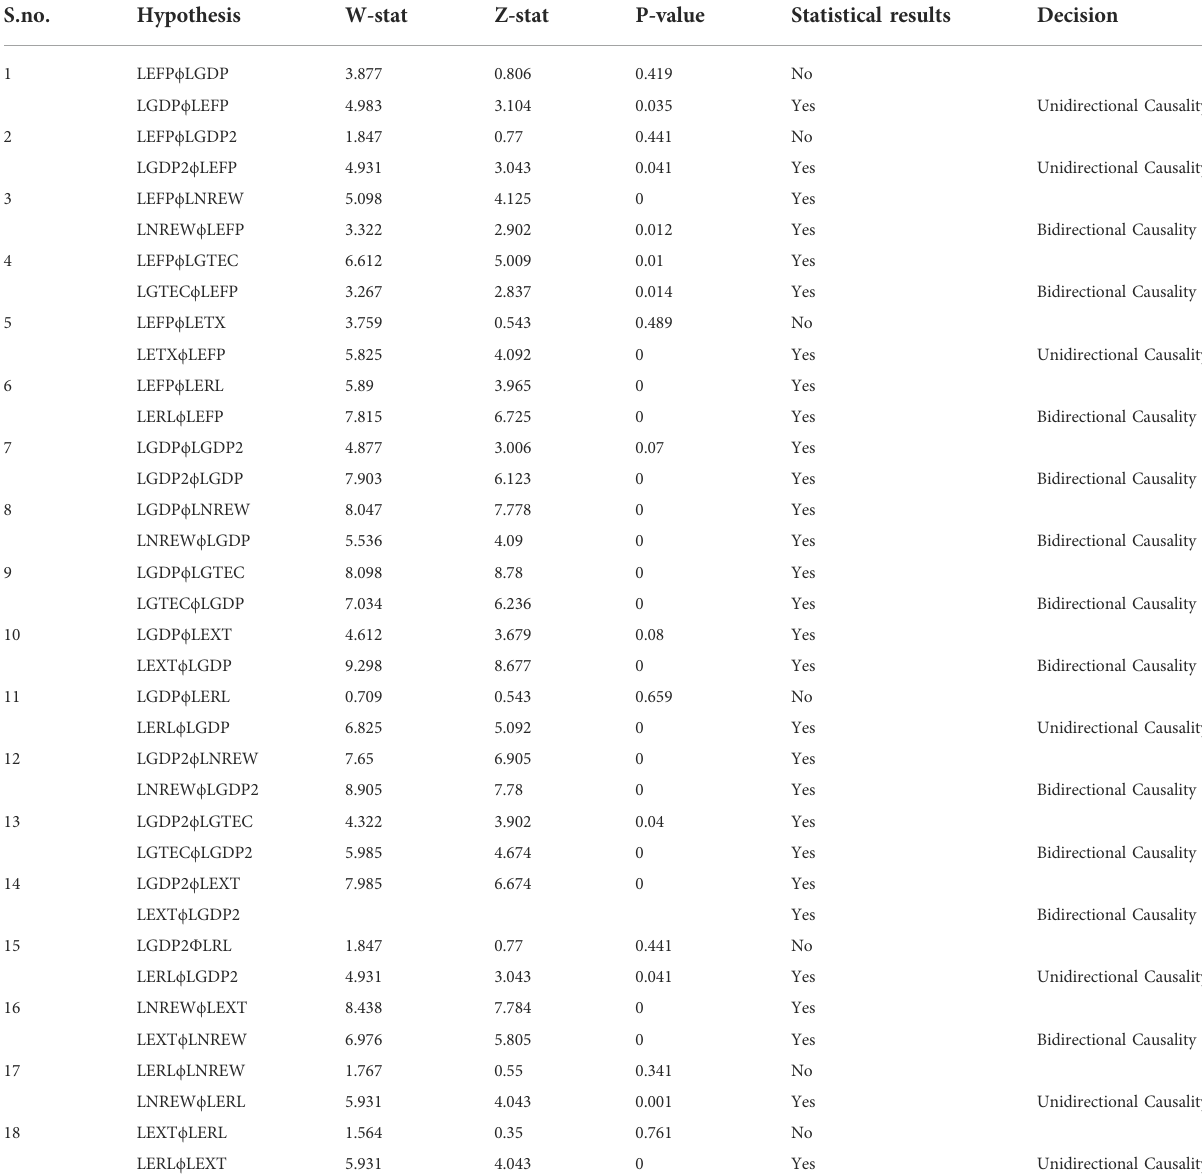
TABLE 8 The statistical fi ndings of the Dumitrescu Hurlin panel